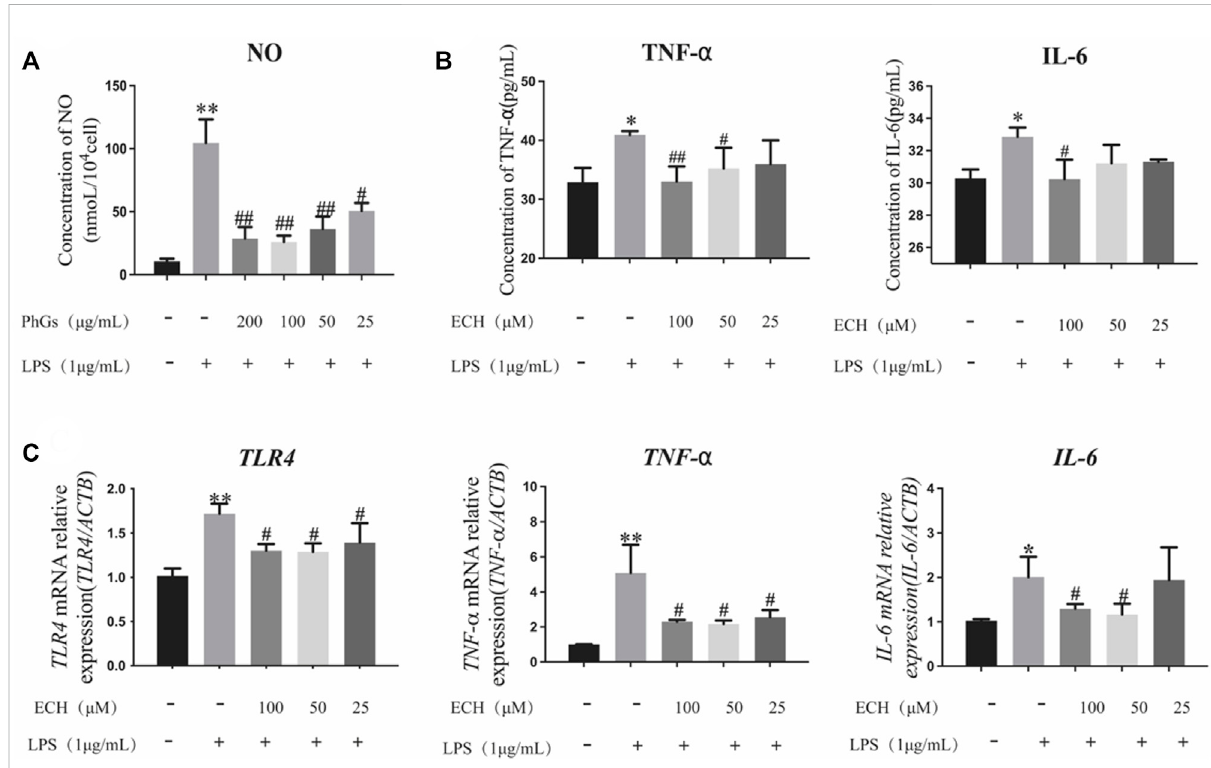
FIGURE 10 Effects of PhGs and ECH on in fl ammatory factors in L02 cells. (A) Expression of NO was analyzed by ELISA. (B) IL-6 and TNF- α expression assessed by ELISA. (C) In fl ammation-related genes TLR4 , TNF- α , and IL-6 were tested by RT-qPCR; * p < 0.05 and ** p < 0.01 compared with the control group; # p < 0.05 and ## p < 0.01 compared with the LPS group; all data are presented as mean ± SD ( n =